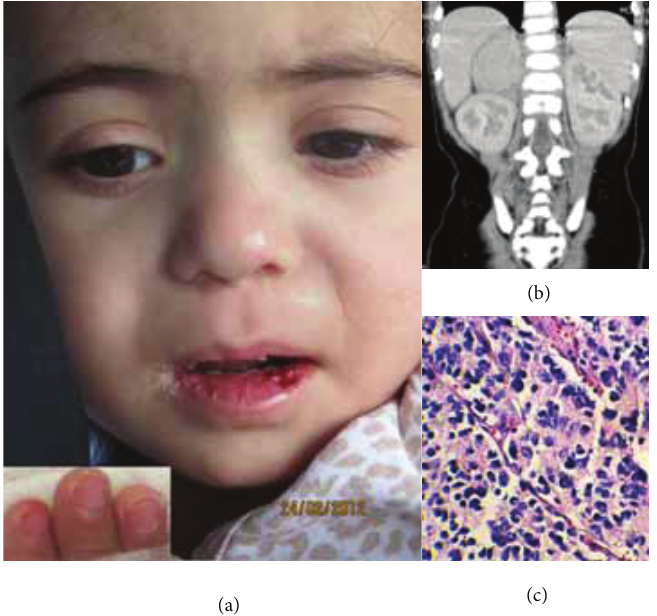
Figure 1: Clinical, radiographic, and pathologic features of a patient with concurrent Kawasaki disease and neuroblastoma. Red fissured lips (a) and desquamation of finger tips (inset). Computed tomography scan showing a mass originating from the right adrenal gland (b). Histopathology showing a tumor composed of predominantly atypical small round cells arranged in sheets, with pleomorphic nuclei, pink cytoplasm, and high mitotic indices